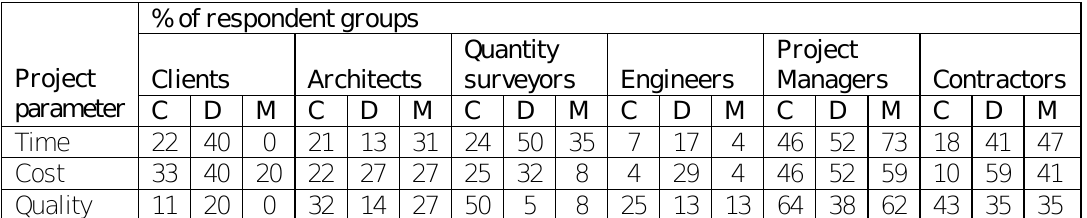
Table 7: Perceptions about whether client objectives with respect to time, cost and quality (as laid down in the brief) are always achieved on building projects (C = Conventional; D = Design and Build; M = Management oriented)